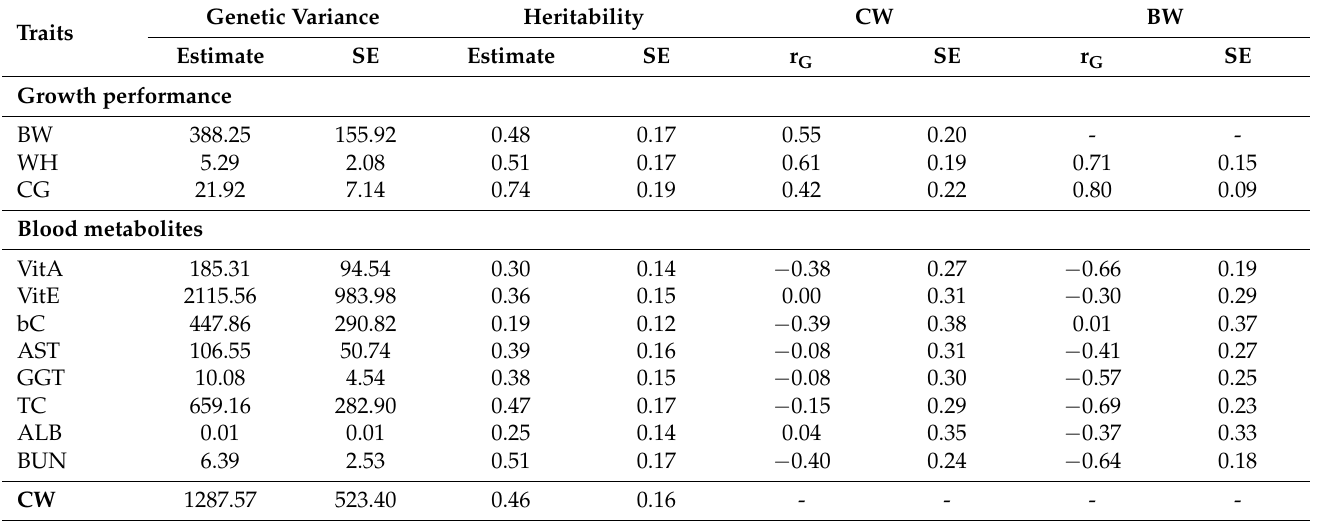
Table 2. Genetic parameter estimations for growth performance, blood metabolites, and carcass weight (CW) in Japanese Black cattle. Growth performance and blood metabolites were measured at the start of fattening (approximately 8–10 months). Genetic (r G ) correlation estimates of growth performance and blood metabolites in CW and body weight (BW). SE: Standard error. Abbreviations of traits are shown in Table